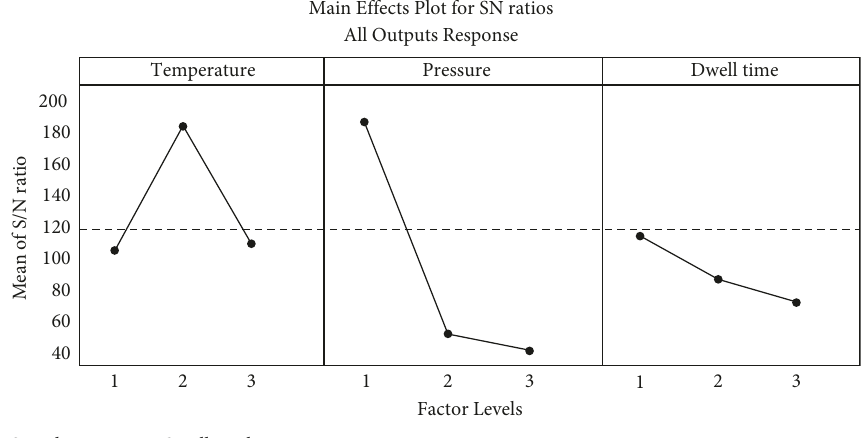
Figure 10: Main effect plot for responses of signal to noise ratio.